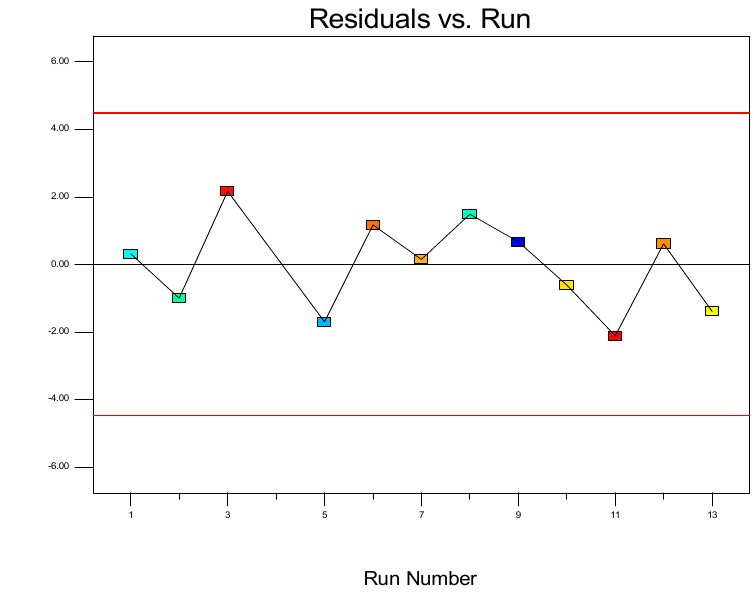
Figure 6. The residuals vs. the experimental run of the COF for the MoS 2